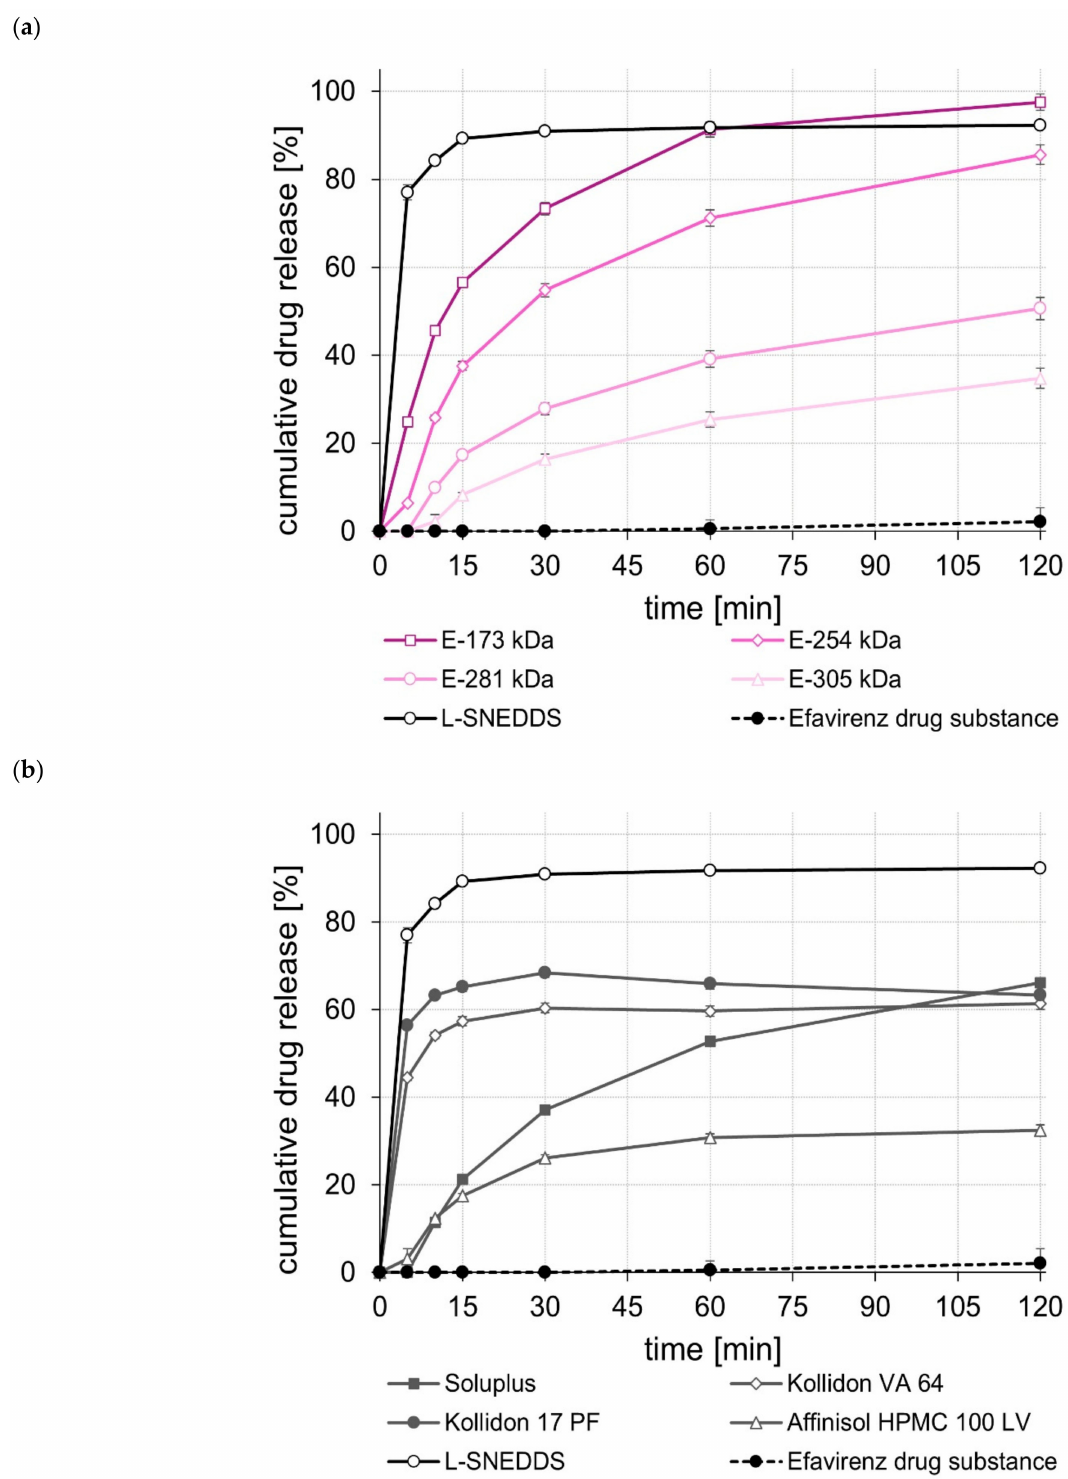
Figure 5. Dissolution profiles of the efavirenz drug substance and efavirenz L- and S-SNEDDS based on ModE ( a ), as well as the efavirenz drug substance and efavirenz L- and S-SNEDDS based on other marketed (co)polymers ( b ) after six months of storage at 30 ◦ C/65% RH in 500 mL 0.1 M HCl in USP apparatus II. Each value designates the mean ± S.D. ( n =